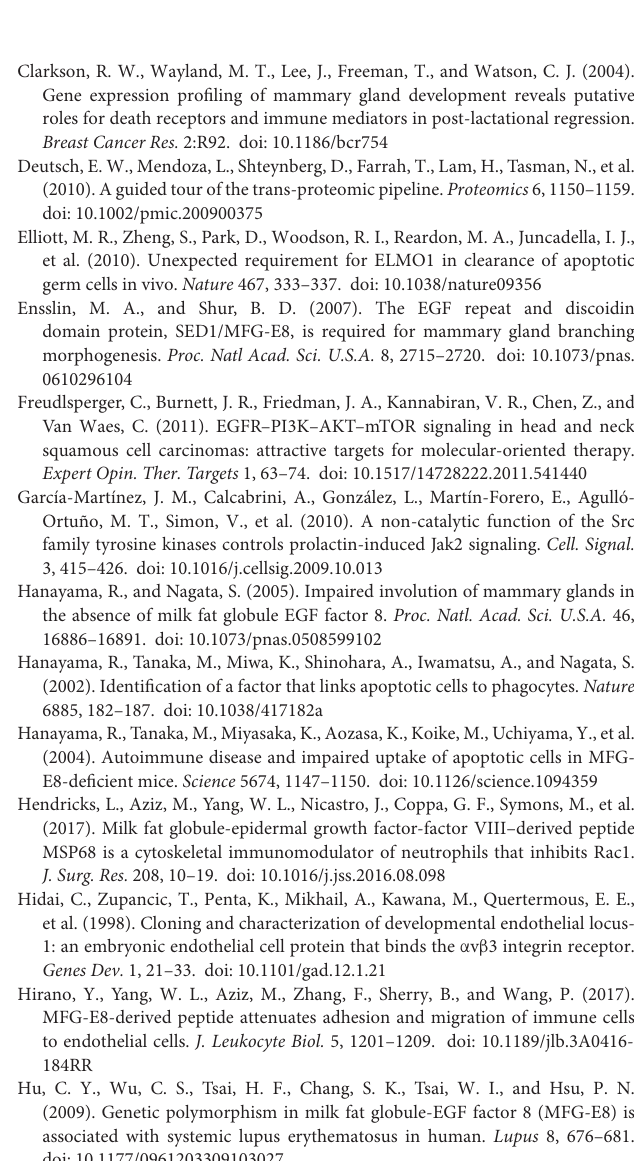
Supplementary Figure 7 | Protein miRNA network of MFGE8–miRNA interactome. The in silico based network analysis of directly interacted miRNAs and their associated proteins partners, which was also identified as significantly ( p < 0.001) differentially expressed in MFGE8 KD proteome. Circular nodes denote the proteins, diamond-shaped nodes are regulation miRNA partners. Dotted lined denotes the edges for miRNA to protein interactions, whereas the broad green line denotes the miRNA targets. Supplementary Table 1 | Total combined identified protein and peptide list together with the identification of all ontological information associated in the Uniprot database. Supplementary Table 2 | Classification of BuMEC proteome using PANTHER (Protein ANalysis THrough Evolutionary Relationships) curated biological database for protein families and their functionally related subfamilies to classify and identify the function of proteins. Supplementary Table 3 | The resulted list of DAVID (the database for annotation, visualization, and integrated discovery) Functional Annotation Tool and typical protein-term enrichment analysis.